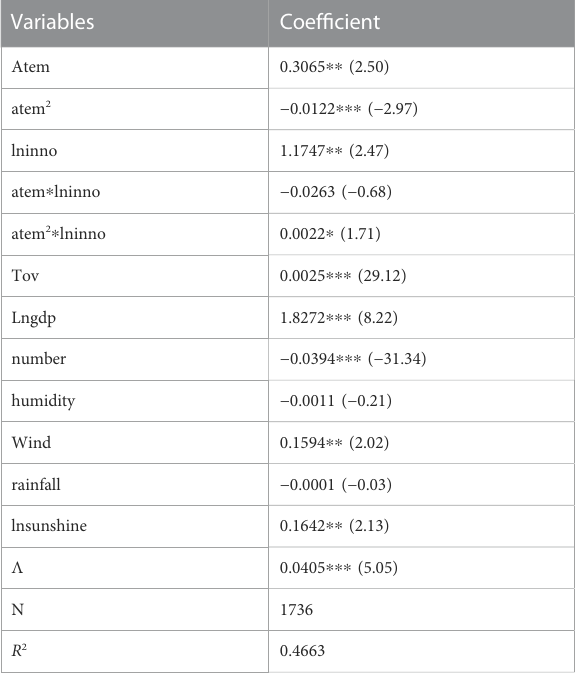
TABLE 5 Results for regression of technological innovation level, temperature and labor productivity.